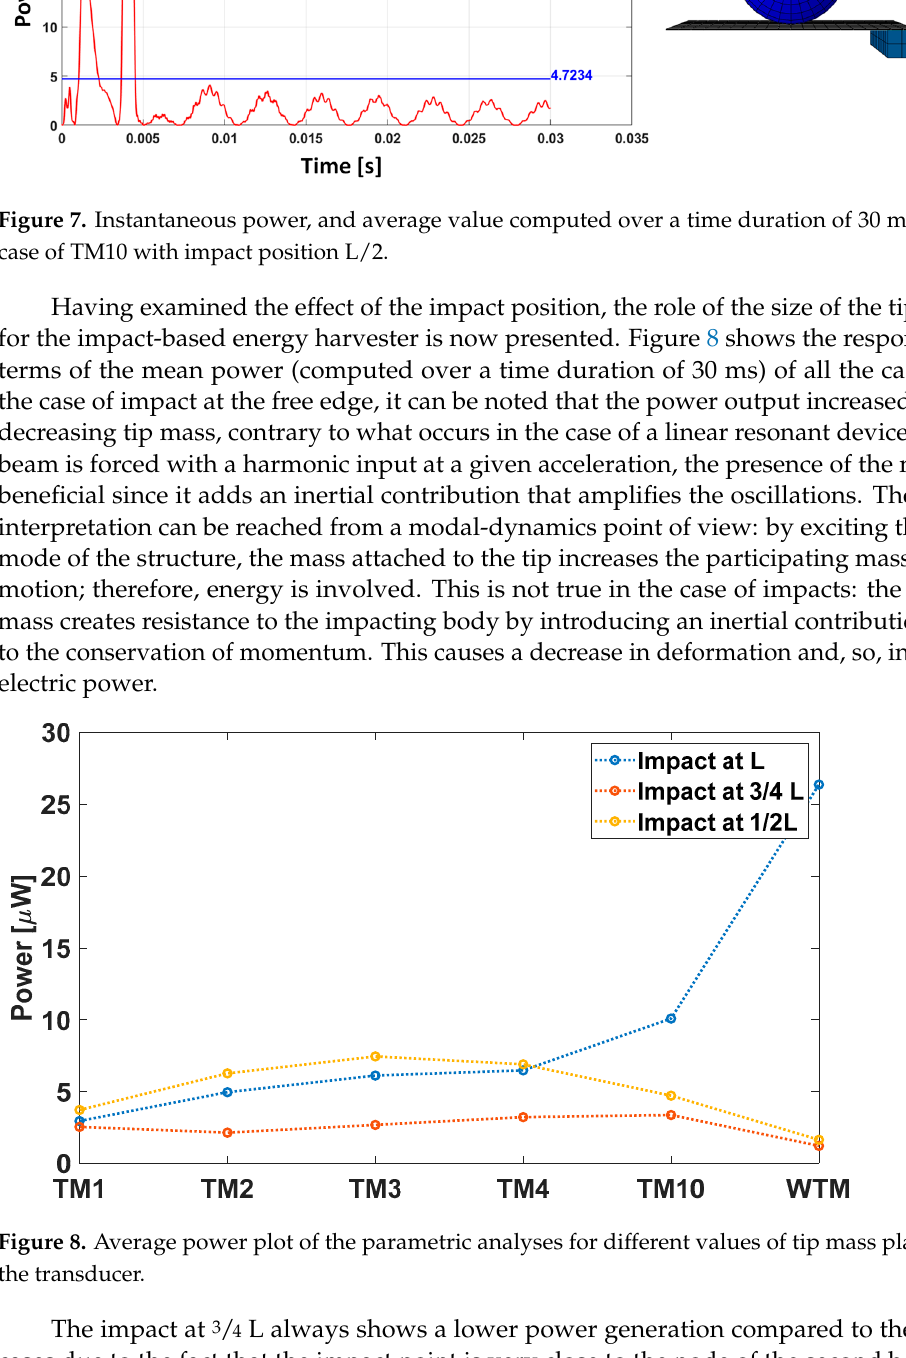
Figure 6. Instantaneous power and average value computed over a time duration of 30 ms in the case of TM10 with impact position ¾ L.